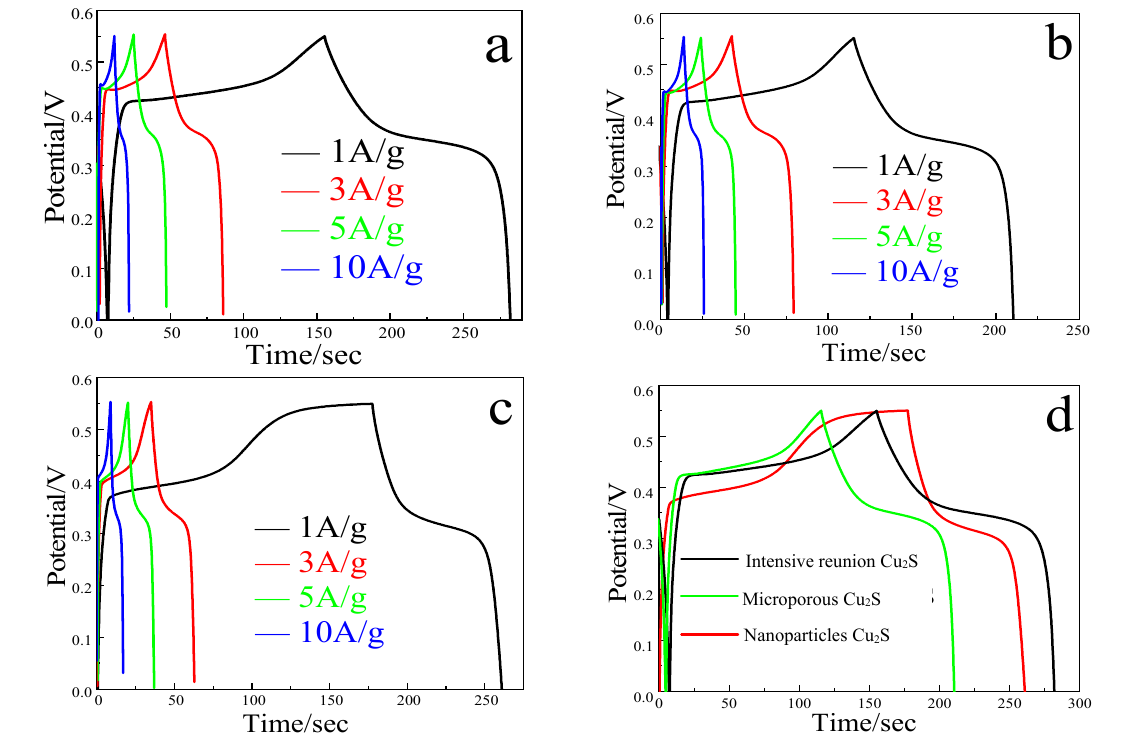
Figure 9. The GCD curves of ( a ) to ( c ) intensive reunion, microporous and nanoparticles three morphologies of Cu 2 S; capacitance retention of ( d ) three different morphologies.